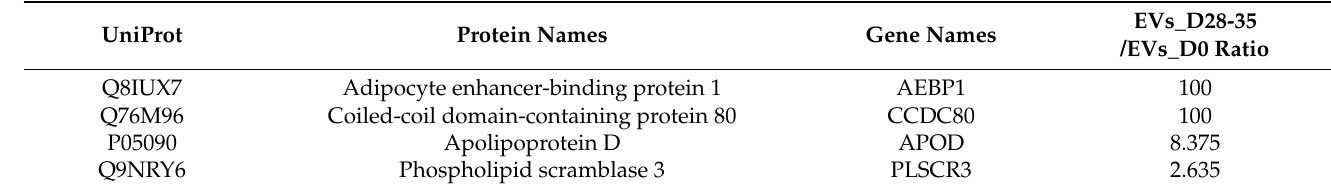
Table 3. The expression/level ratio of selected anti-adipogenic proteins in EVs_D28-35 compared with that in EVs_D0.